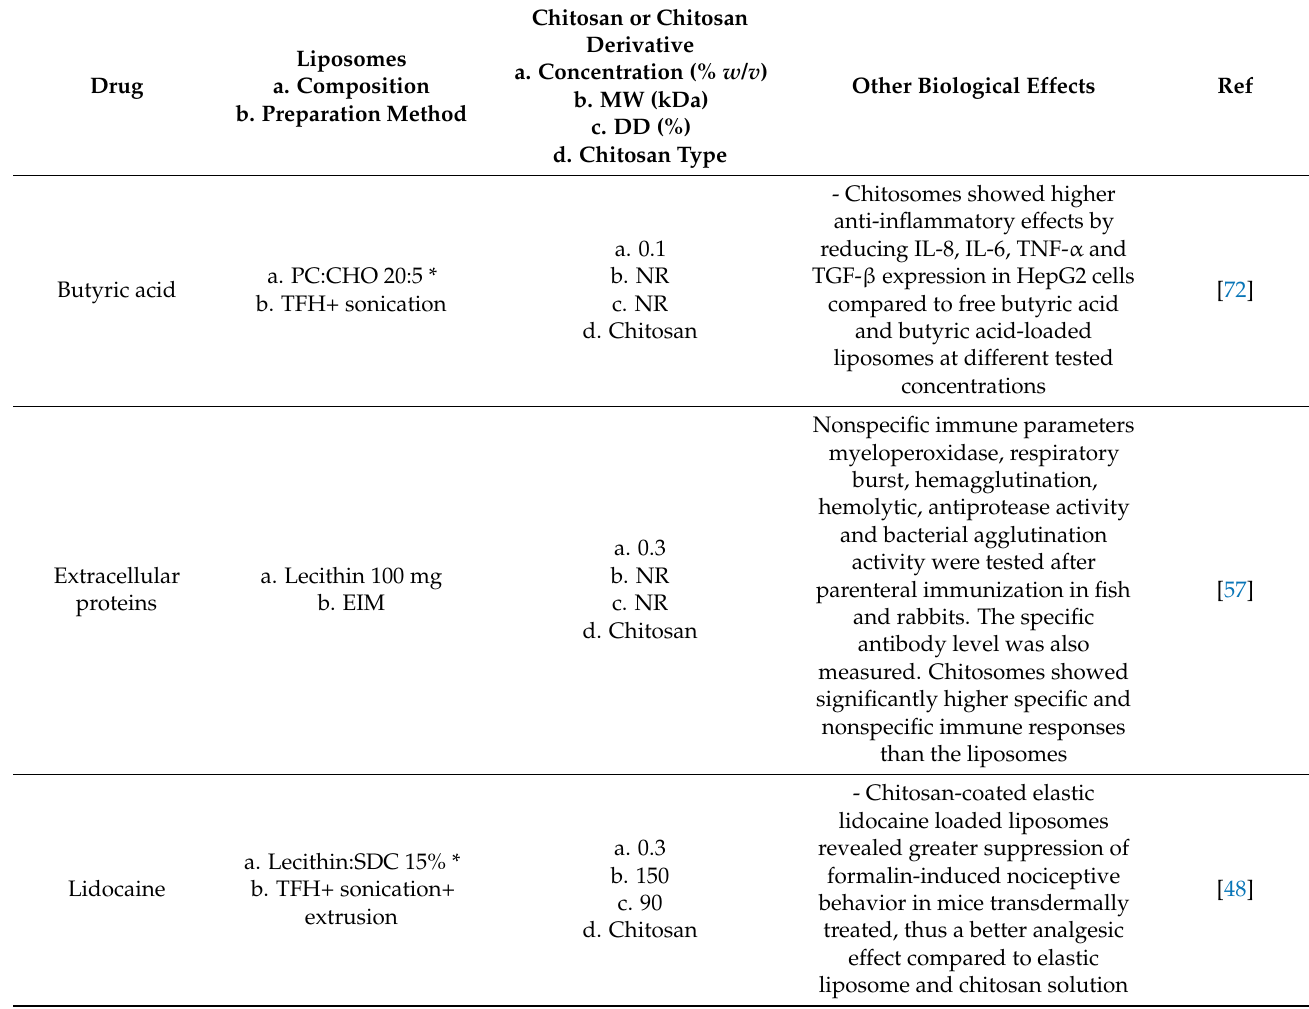
Table 12. Other biological effects of drugs: conventional liposomes and chitosomes. The liposomal composition is indicated in the table in molar ratio except when * exists, indicating a weight ratio ( w/w